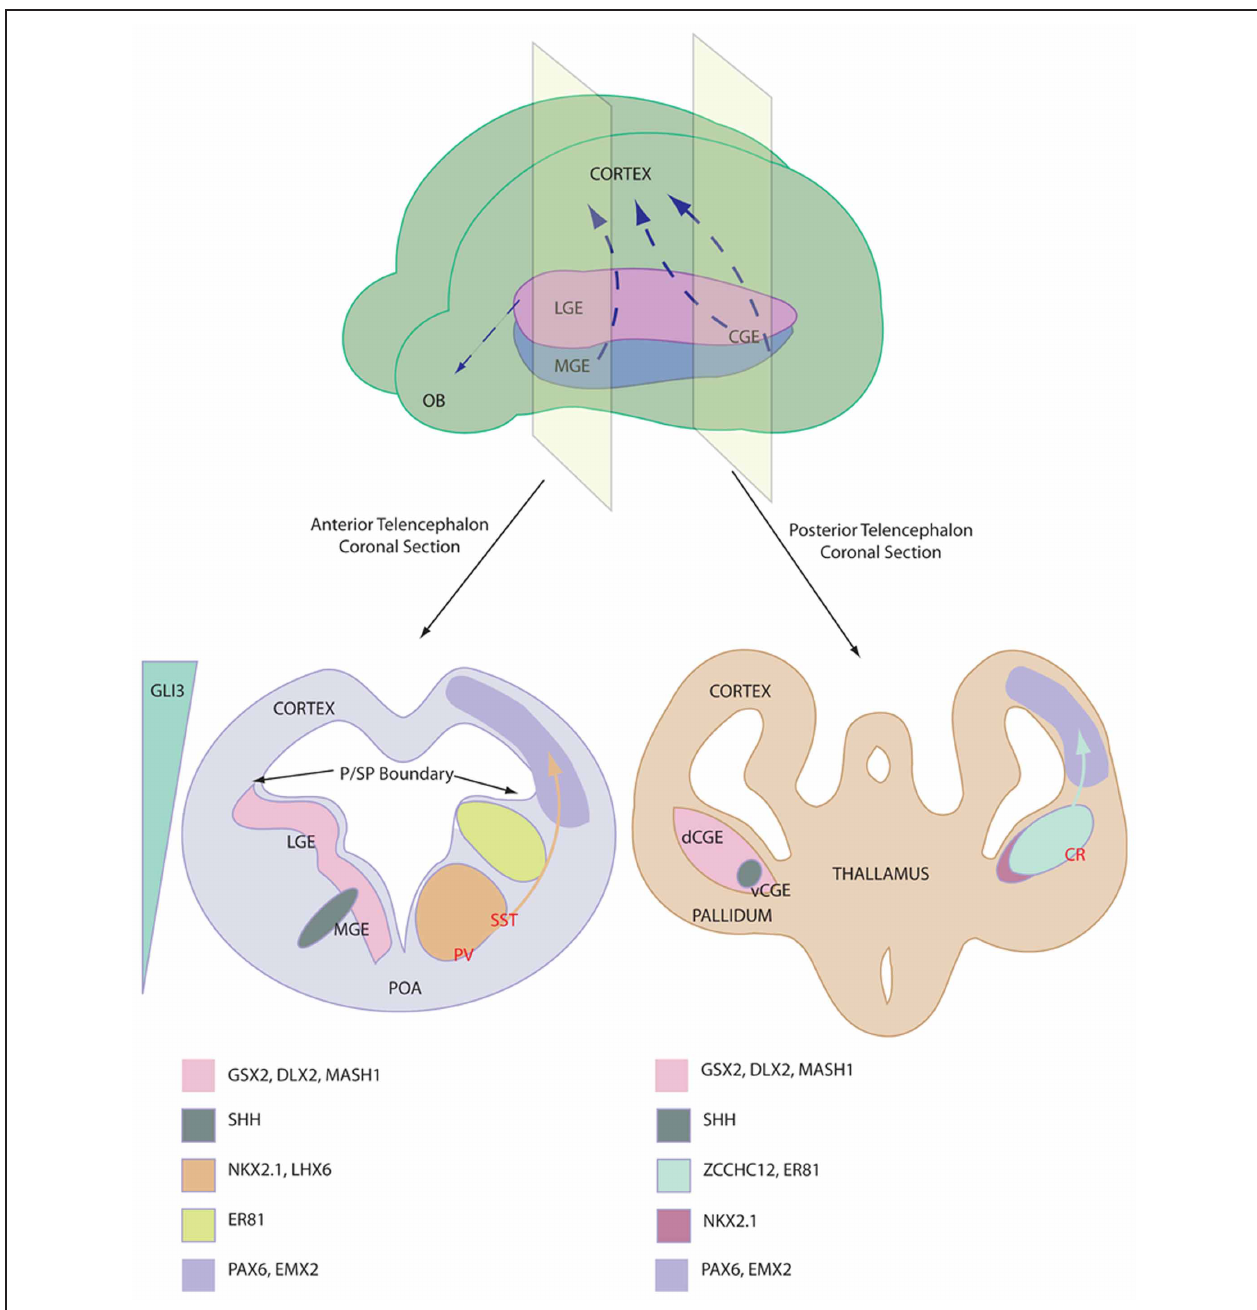
niches of the ganglionic eminences. Relative origin of interneuron subtypes are shown in RED. Note the Shh expression domains and the reciprocal Gli3 expression. Abbreviations; LGE, lateral ganglionic eminence; MGE, medial ganglionic eminence; CGE, caudal ganglionic eminence (v ventral and d dorsal); OB, olfactory bulb; P/SP, pallial subpallial; POA, preoptic area; PV, Parvalbumin; SST, Somatostatin; CR,